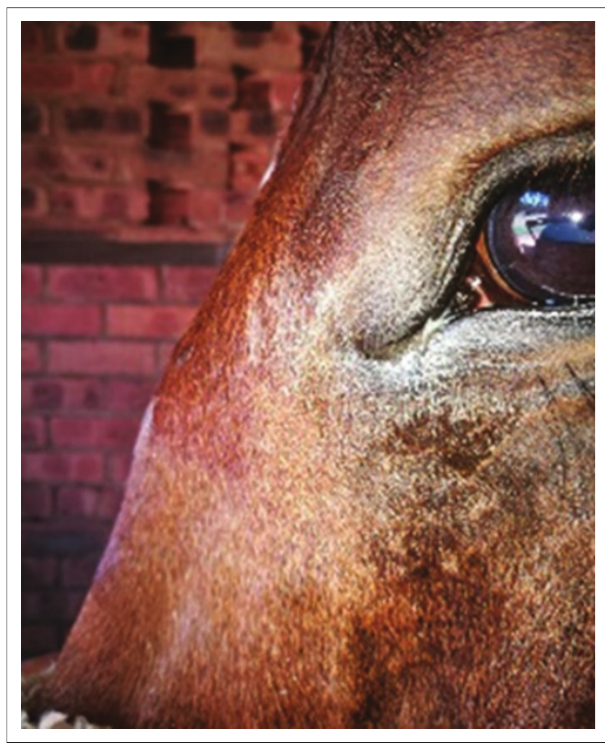
FIGURE 3: A left-sided photograph of the head at initial presentation showing a firm swelling at the nasofrontal suture line and a firm swelling adjacent to the medial canthus of the left eye consistent with the nasolacrimal suture line.